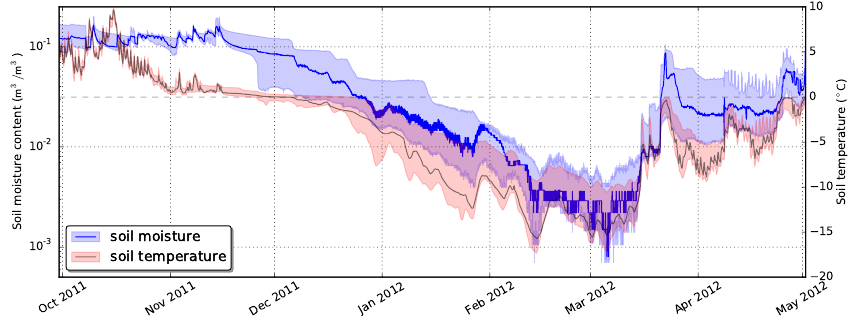
Figure 6. Median ground temperatures (red) and soil moisture (blue) measured at seven sites within the study area. The light coloured areas show the 25% and 75% percentiles of temperatures and soil moisture content measured at a given date.